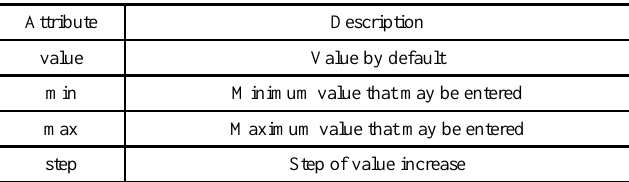
Fig. 9. “Number” type field display.